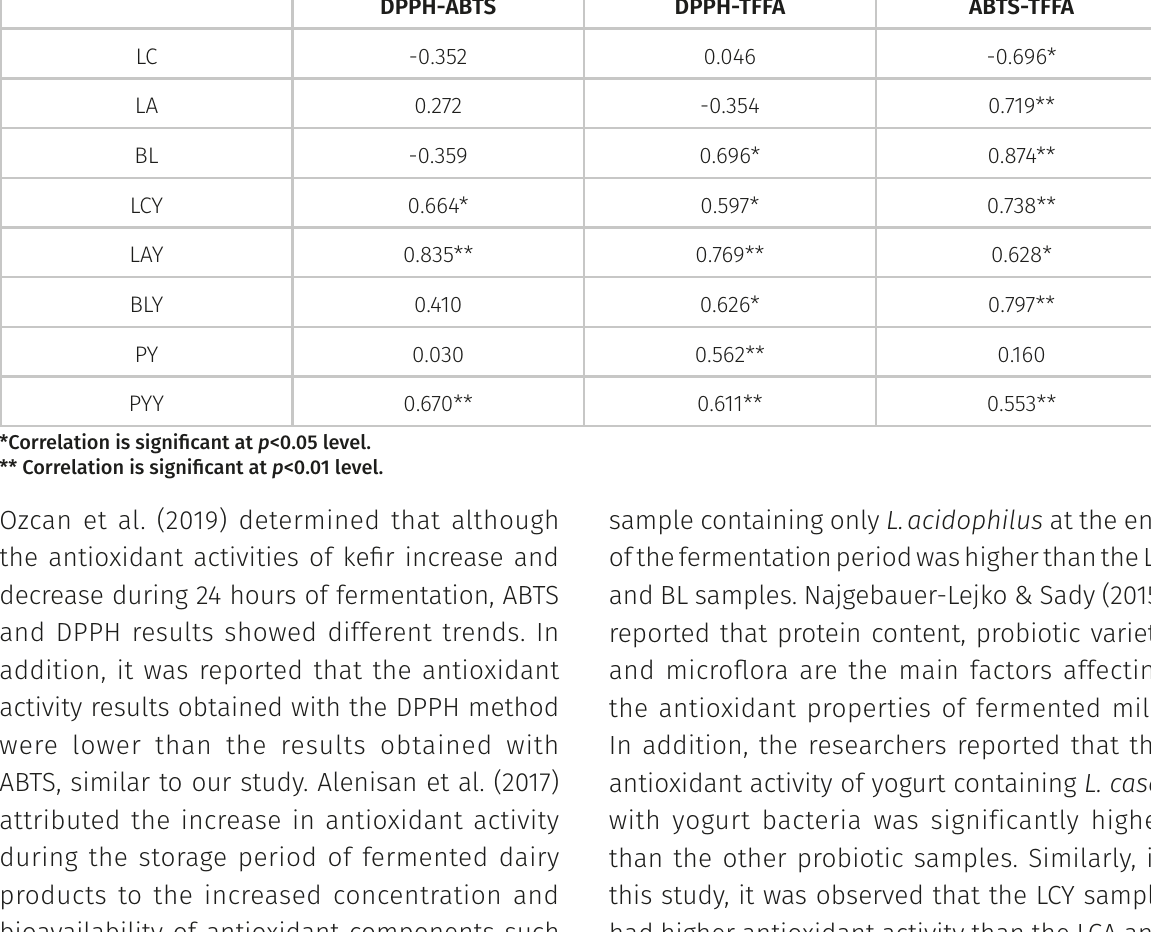
Table IV. Correlation coefficents between DPPH, ABTS and TFFA methods.